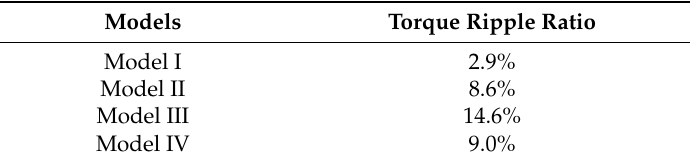
Table 2. Comparison of torque ripple ratios in different models.